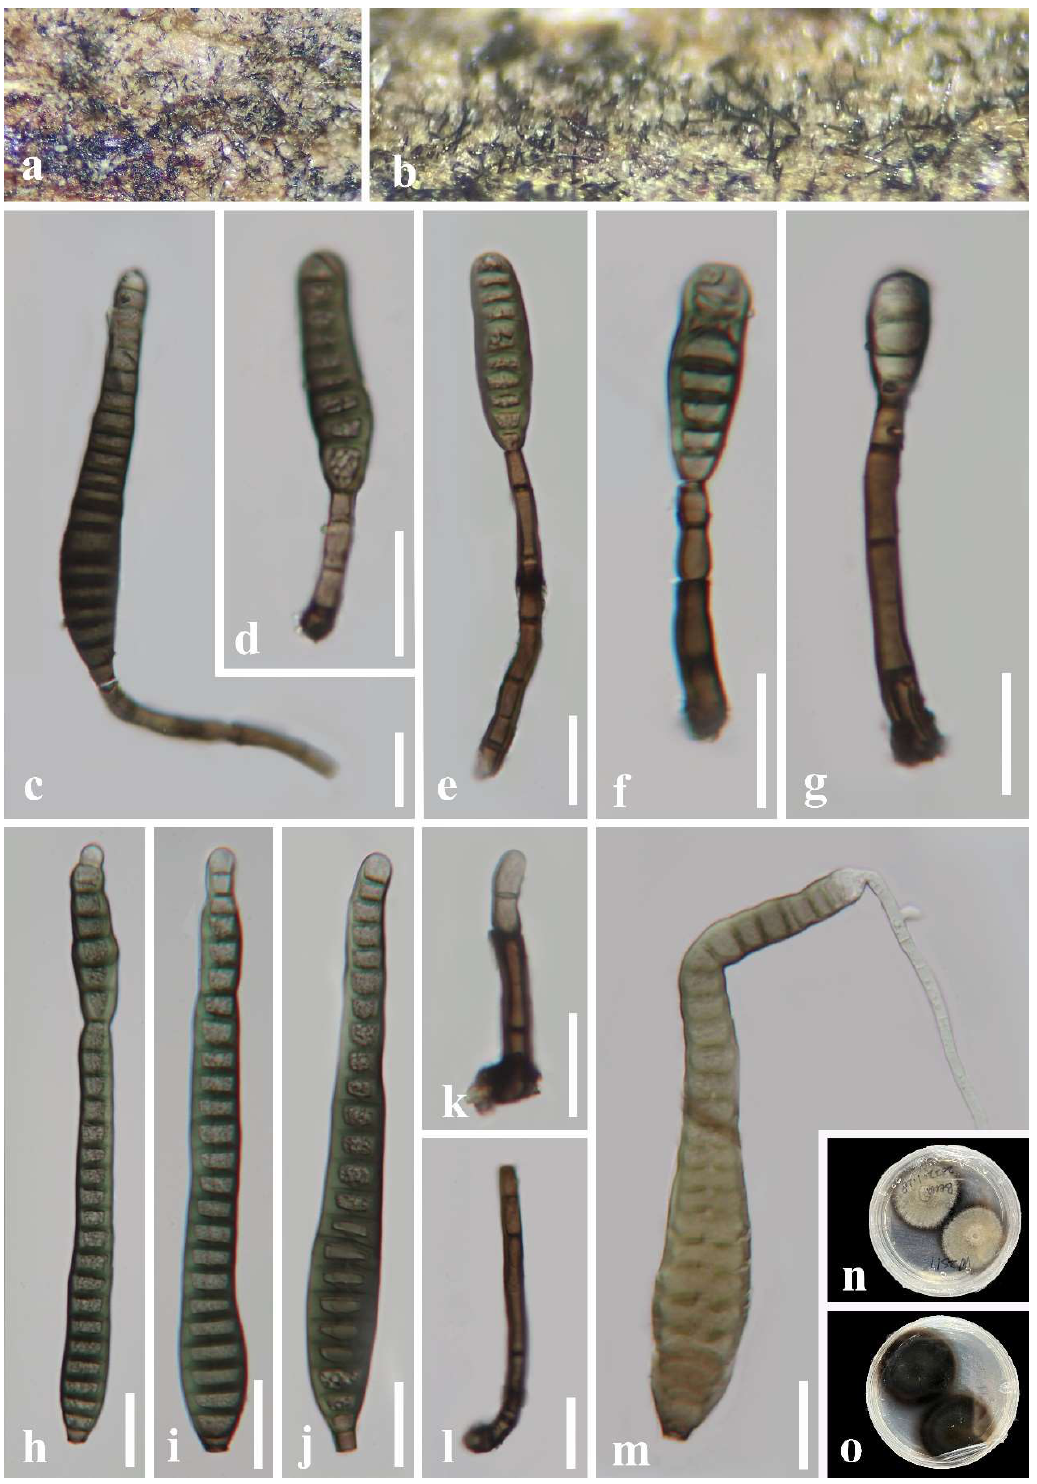
Figure 6. Distoseptispora septata (HKAS 123759, holotype). ( a , b ) Colonies on the host surface. ( c – g ) Conidiophores and conidiogenous cells bearing conidia. ( h – j ) Conidia. ( k , l ) Conidiophores and conidiogenous cells. ( m ) Germinating conidium. ( n , o ) Colonies on PDA, n from above, o from reverse. Scale bars: ( c – m ) 20 μm. Distoseptispora tropica J. Ma and Y.Z. Lu, sp. nov., Figure 7. Index Fungorum number: IF559689; Facesoffungi number: FoF11335.